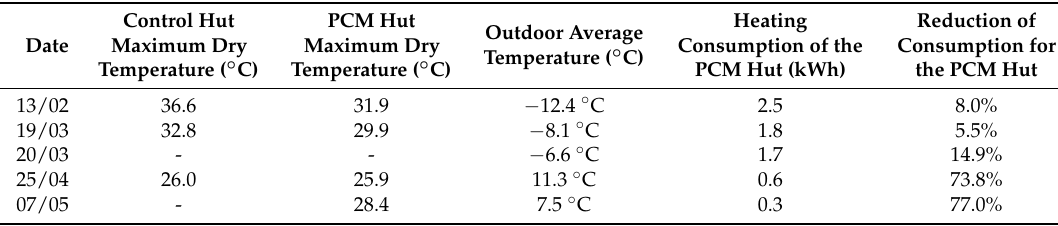
Table 2. Huts behaviour for sunny days.